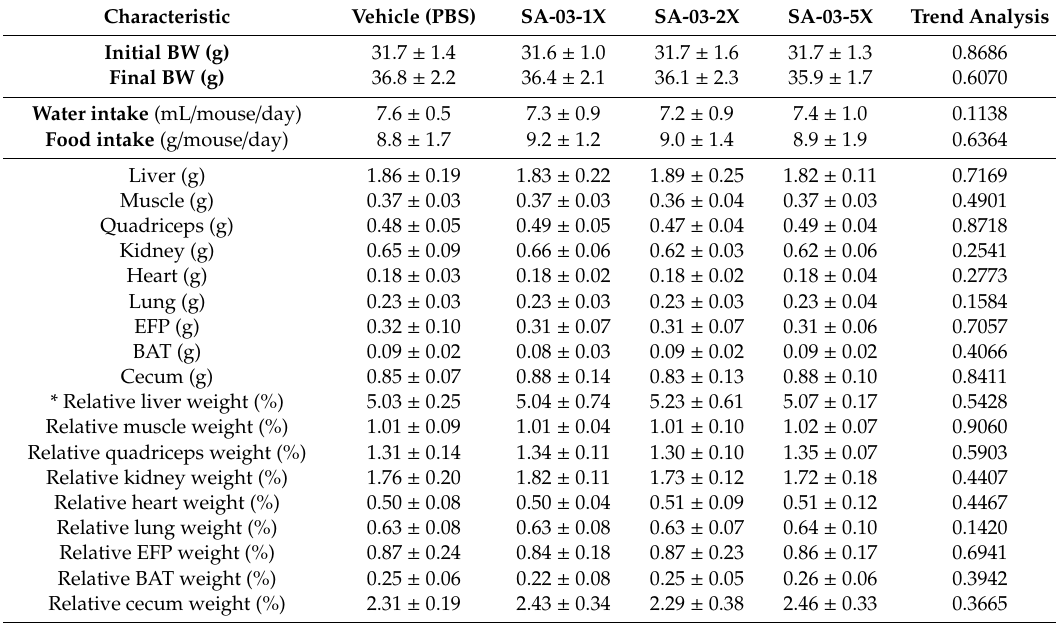
Figure 1. Effect of SA-03 supplementation on body weight of mice. Data are expressed as mean ± SD for n = 10 mice per group. Table 1. Effect of SA-03 supplementation on various parameters.